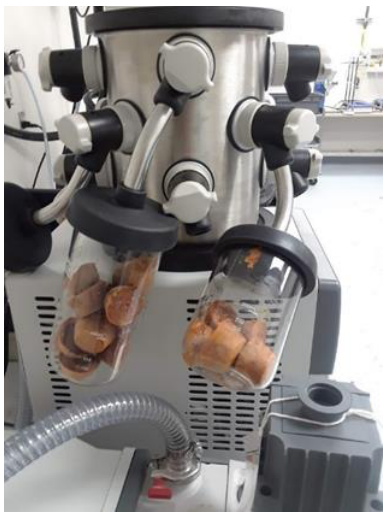
Figure 3. Freeze drying of